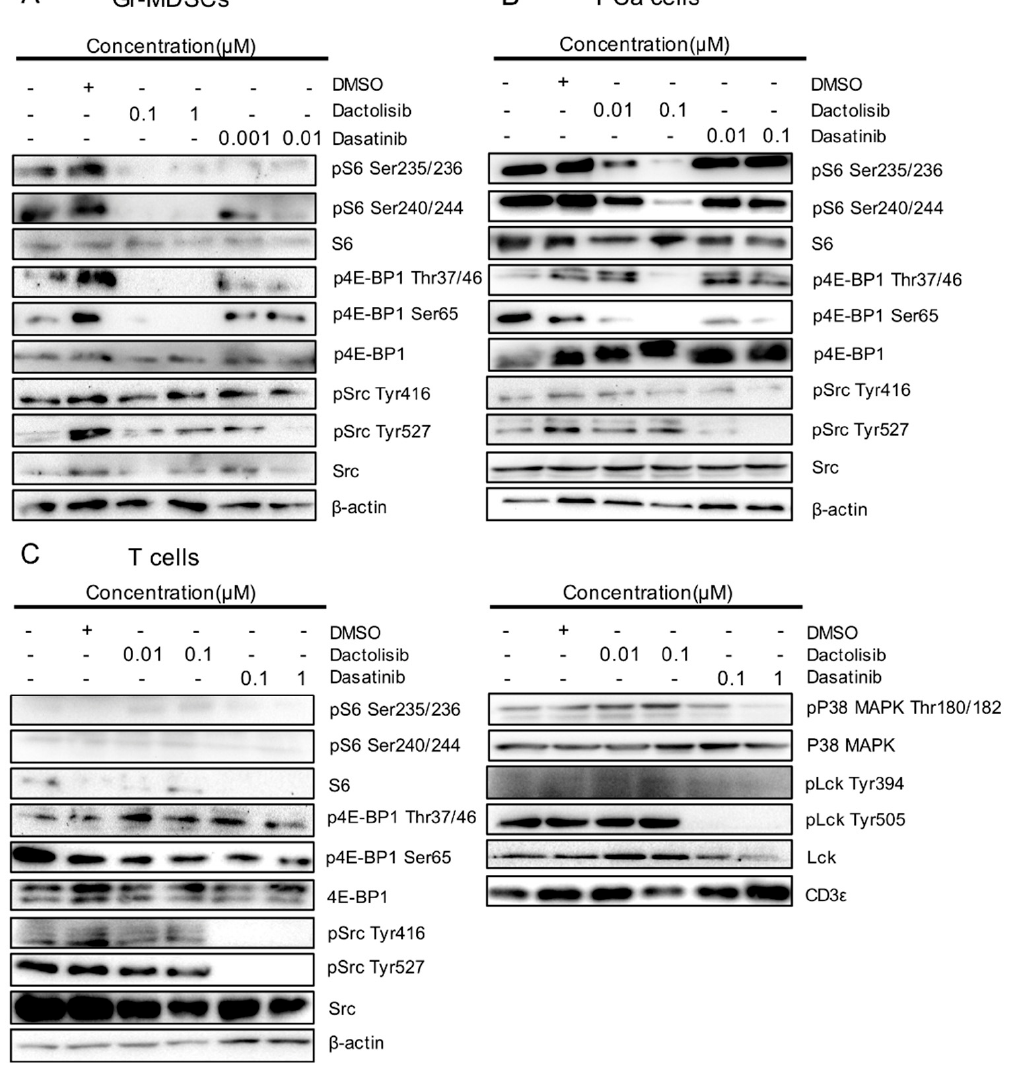
Figure 4. Validation of cell type-specific effect on S6, 4E-BP1, Src and p38 MAPK by Dactolisib and Dasatinib. Cell lysates used for RPPA were used to detect indicated total proteins and their phosphorylated forms by western blot for ( A ) Gr-MDSCs, ( B ) PCa cells and ( C ) T cells. The sign + and – denote the presence and absence of DMSO, Dactolisib or Dasatinib, respectively.